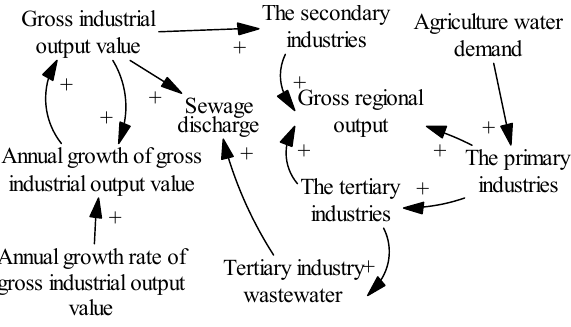
Figure 6. Workflow for the economic subsystem.